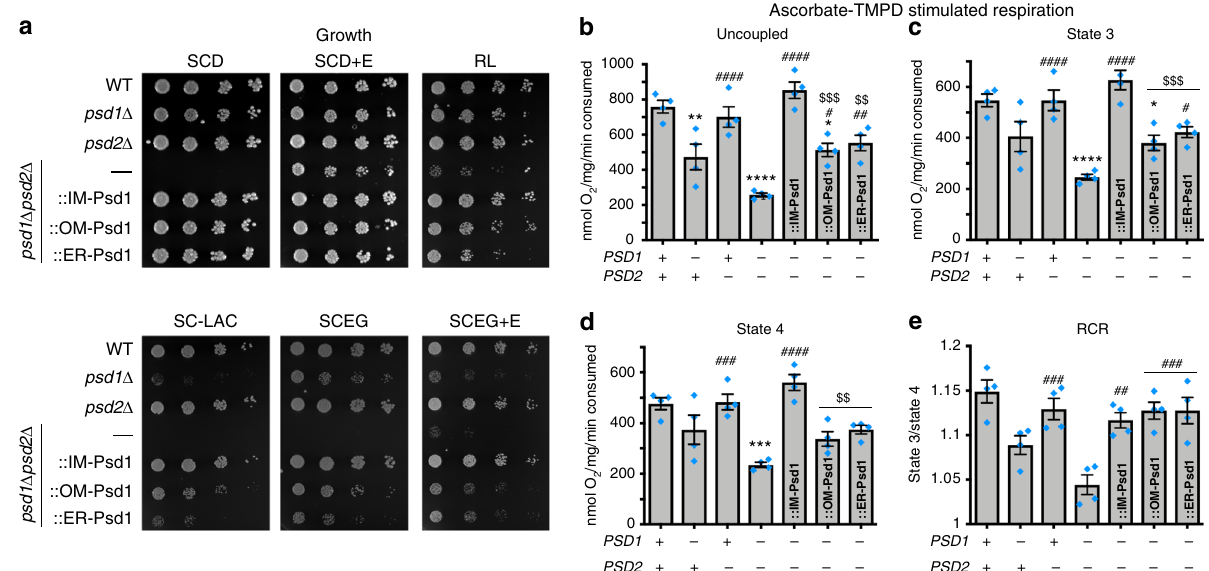
Fig. 4 OM-Psd1 and ER-Psd1 OXPHOS function phenocopies psd1 Δ . a The indicated strains were spotted and incubated at 30 °C for 2 days on SCD with or without ( + / − ) 2 mM ethanolamine ( + E) and for 5 days on rich lactate (RL), SC lactate (SC-LAC), and SCEG with or without ( + / − ) 2 mM ethanolamine ( + E). b – e O 2 consumption measurements from mitochondria isolated from yeast grown in rich lactate using ascorbate-TMPD as a substrate. b The maximal respiratory rate was recorded after the addition of CCCP, ( c ) state 3 respiration was assessed after addition of ADP, and ( d ) state 4 respiration was recorded following ADP depletion. e The respiratory control ratio (RCR) is calculated by dividing state 3 by state 4 respiratory rates. Statistical comparisons (ns, P > 0.05; 1 symbol P ≤ 0.05; 2 symbols P ≤ 0.01; 3 symbols P ≤ 0.001; 4 symbols P ≤ 0.0001) vs. WT (asterisk), psd1 Δ psd2 Δ (number sign), or IM-Psd1 (dollar sign) were performed by one-way ANOVA with Tukey ’ s multiple comparison test (mean ± S.E.M. for n = 4